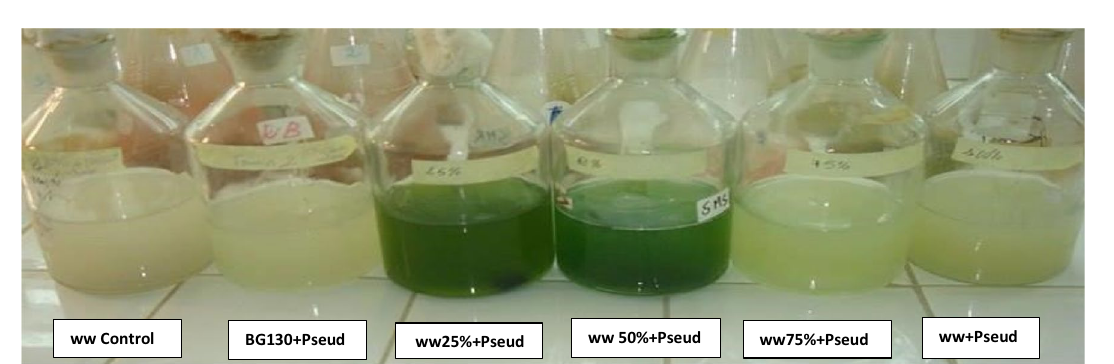
Fig. 3 Appearance of wastewater samples at the end of